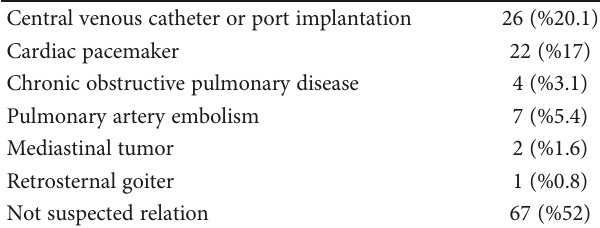
Table 3: Etiological